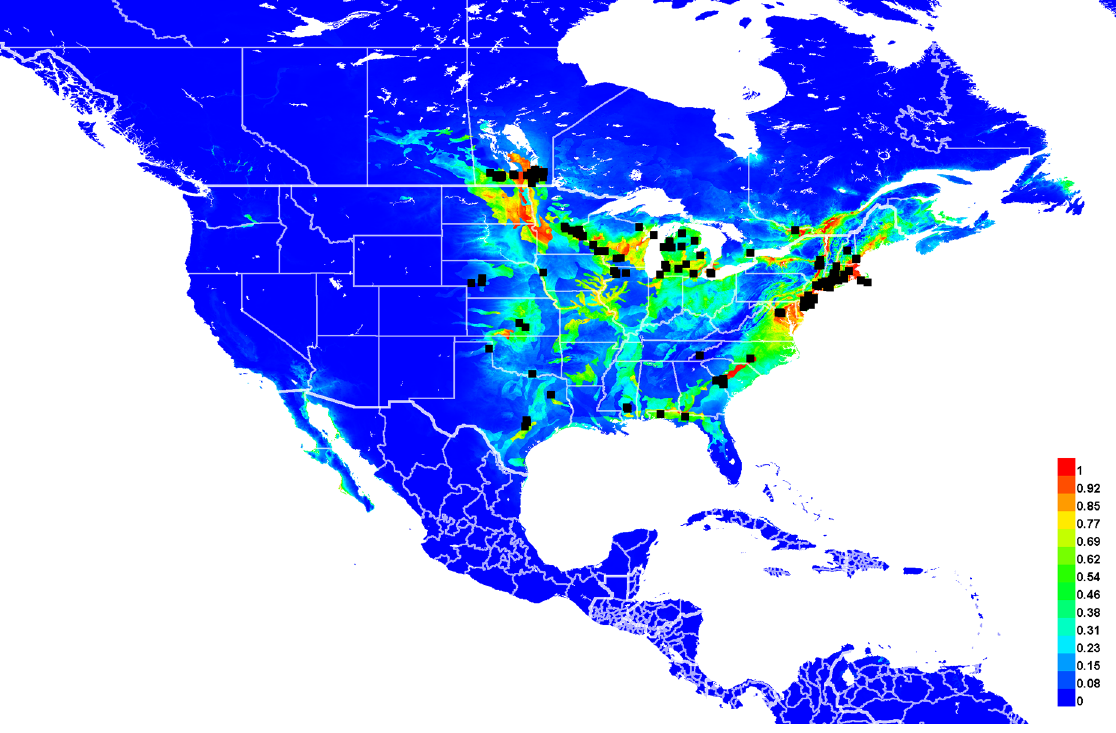
Fig. 88. Georeferenced collection records of Lasioglossum ( D. ) vierecki (Crawford, 1904) (black squares) and predicted distribution by maximum entropy ecological niche modeling in Maxent (colour shading). Warmer colours indicate higher cloglog probability of